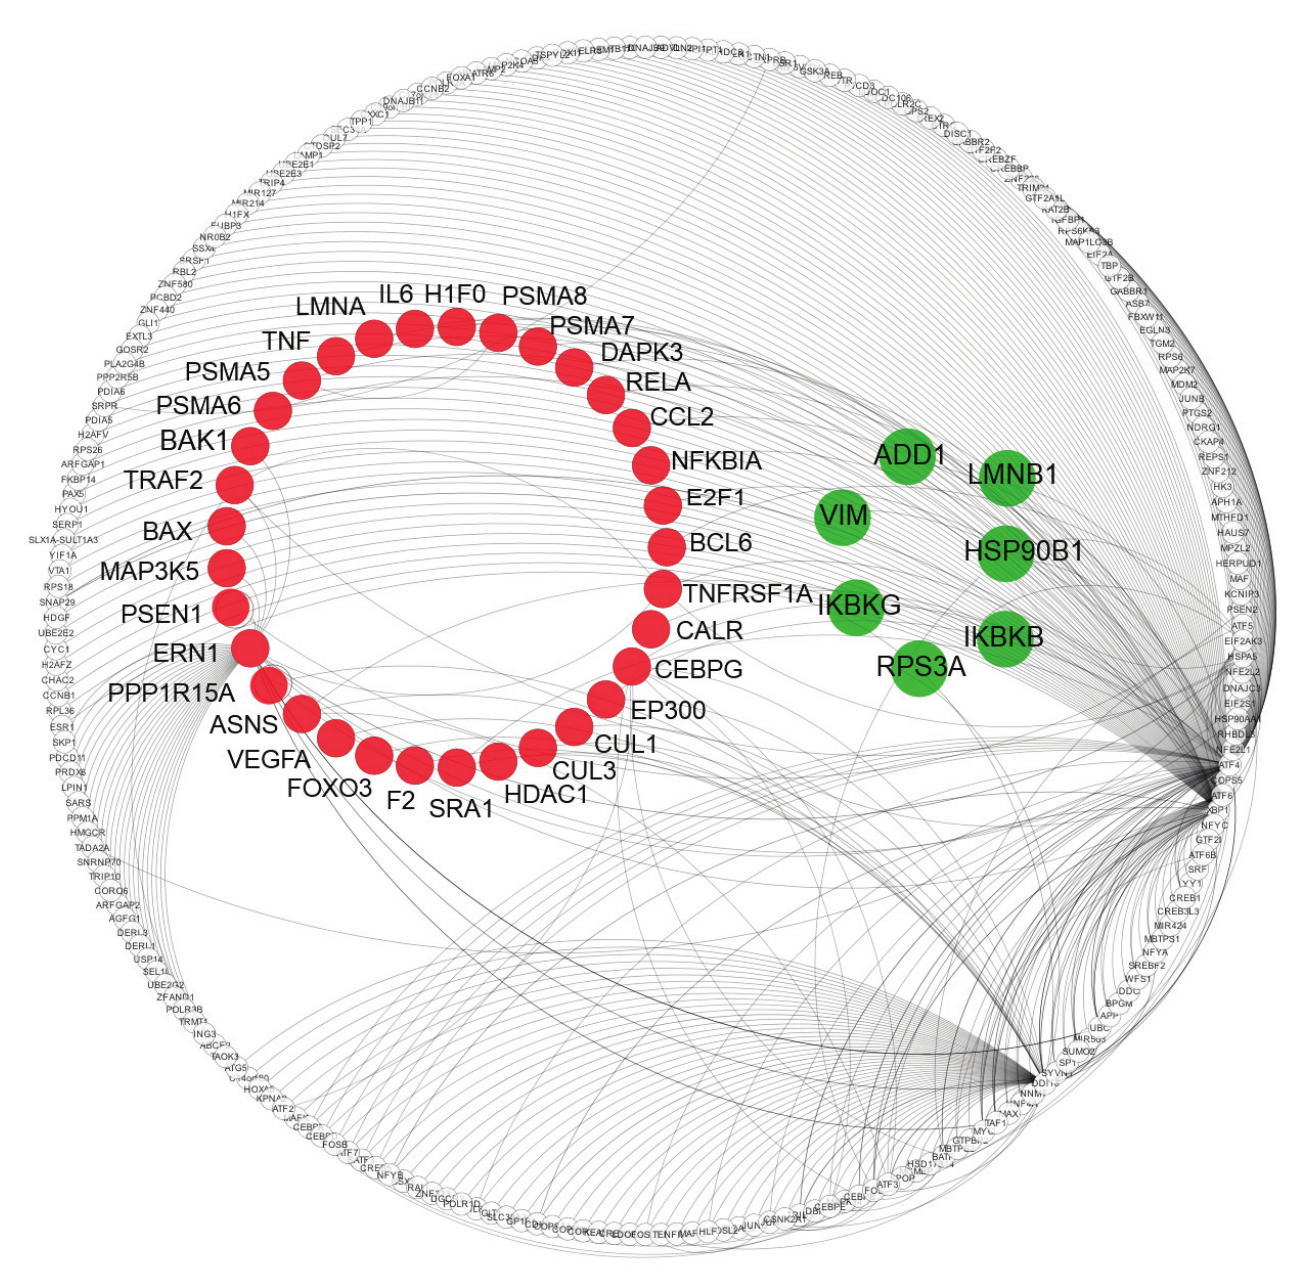
Figure 6. Network representation of UPR-apoptosis connection. The network displays UPR proteins and their interactions. Nodes indicate proteins and lines represent molecular interactions between them as derived from UniHI and HDNetDB. UPR proteins which are also associated with apoptosis are highlighted in red, while UPR proteins that are both associated with apoptosis and identified as HTT interactors are in green.